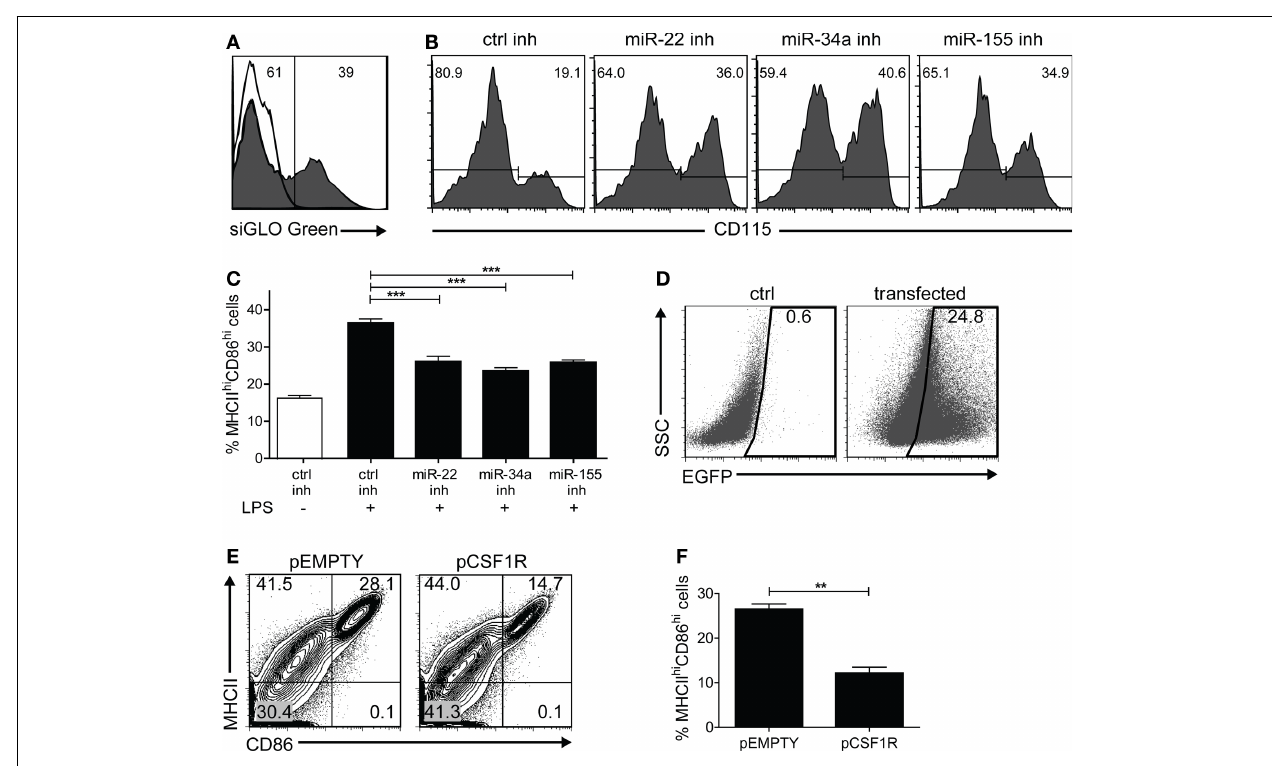
expressed as mean ± SEM from five experiments; *** p < 0.0001. (D) BM cultures stimulated with GM-CSF were nucleofected on day 6 of culture with an expression vector encoding Csf1r (pCSF1R) or the empty backbone vector (pEMPTY) together with an EGFP expression vector in a 4:1 ratio to assess transfection efficiency. LPS was added on day 8 to enforce DC maturation. In this experiment, transfection led to detectable EGFP expression in 24% of the cells. 7AAD staining confirmed that both vectors used did not cause significant differences in cell viability as a result of transfection (data not shown). (E,F) Cell surface marker expression of Csf1r -transfected EGFP + cells was analyzed on day 9 using flow cytometry. Contour plots of transfected cells (E) and quantitation of viable MHCII hi CD86 hi EGFP + mDC (F) after overnight LPS exposure. Data are expressed as mean ± SEM from three experiments; ** p =